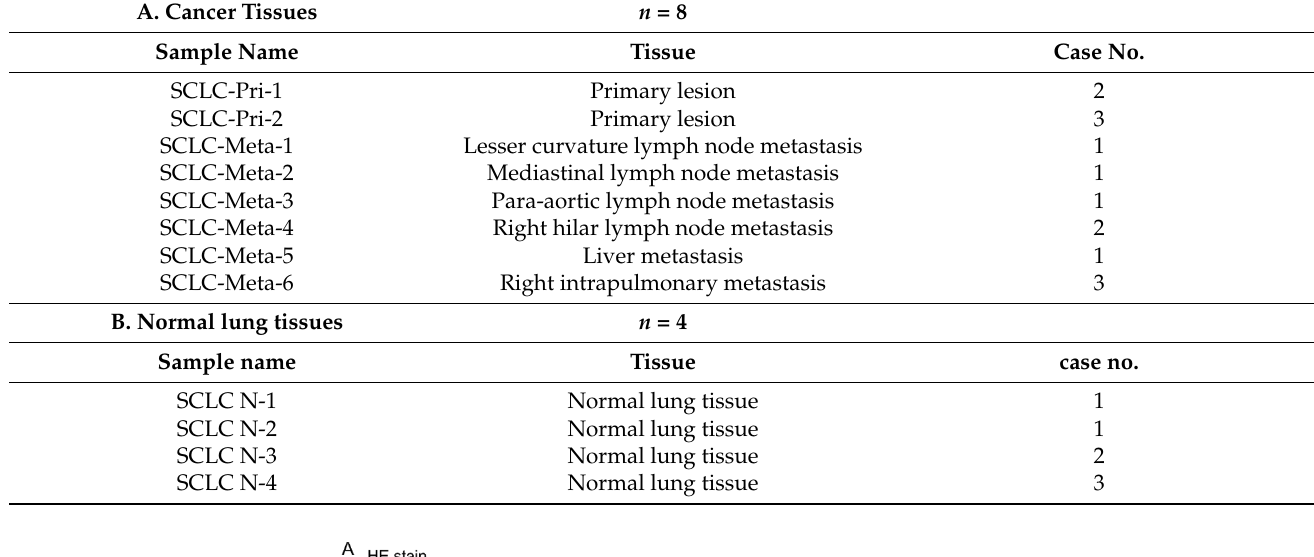
Table 2. Site of sample collection for microarray expression analysis.